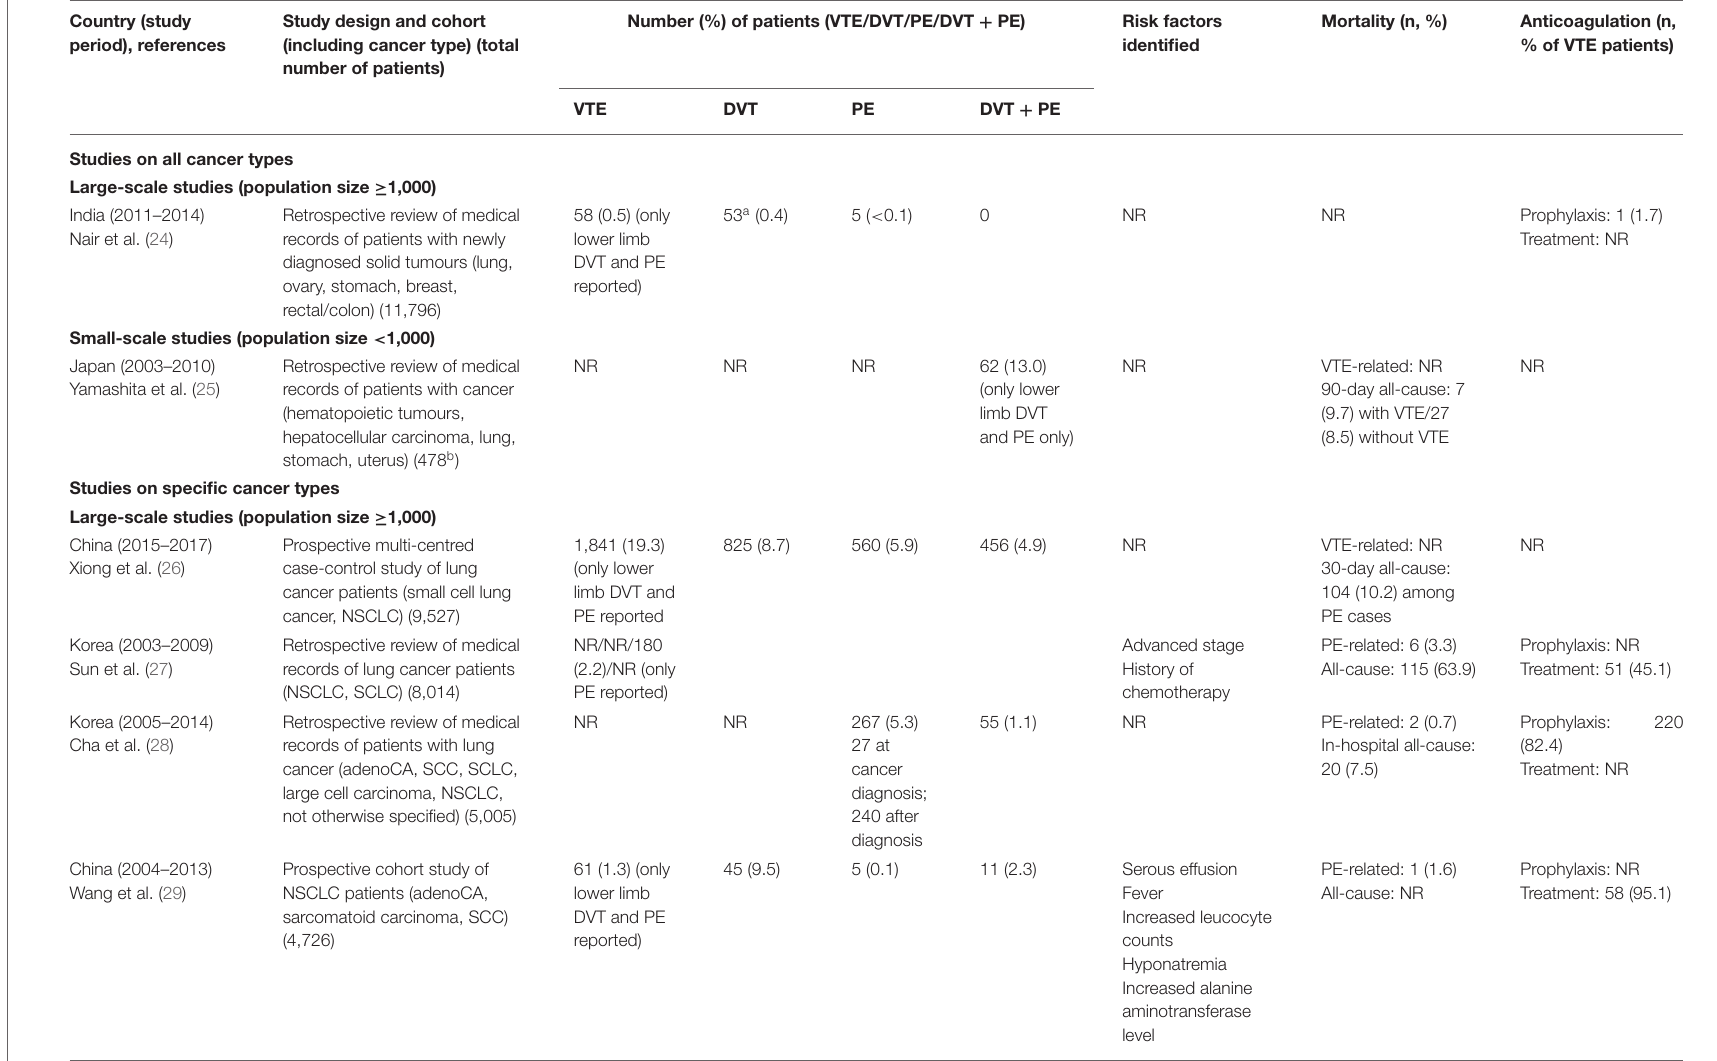
TABLE 1 | VTE rates in studies involving cancer patients. Country (study period),